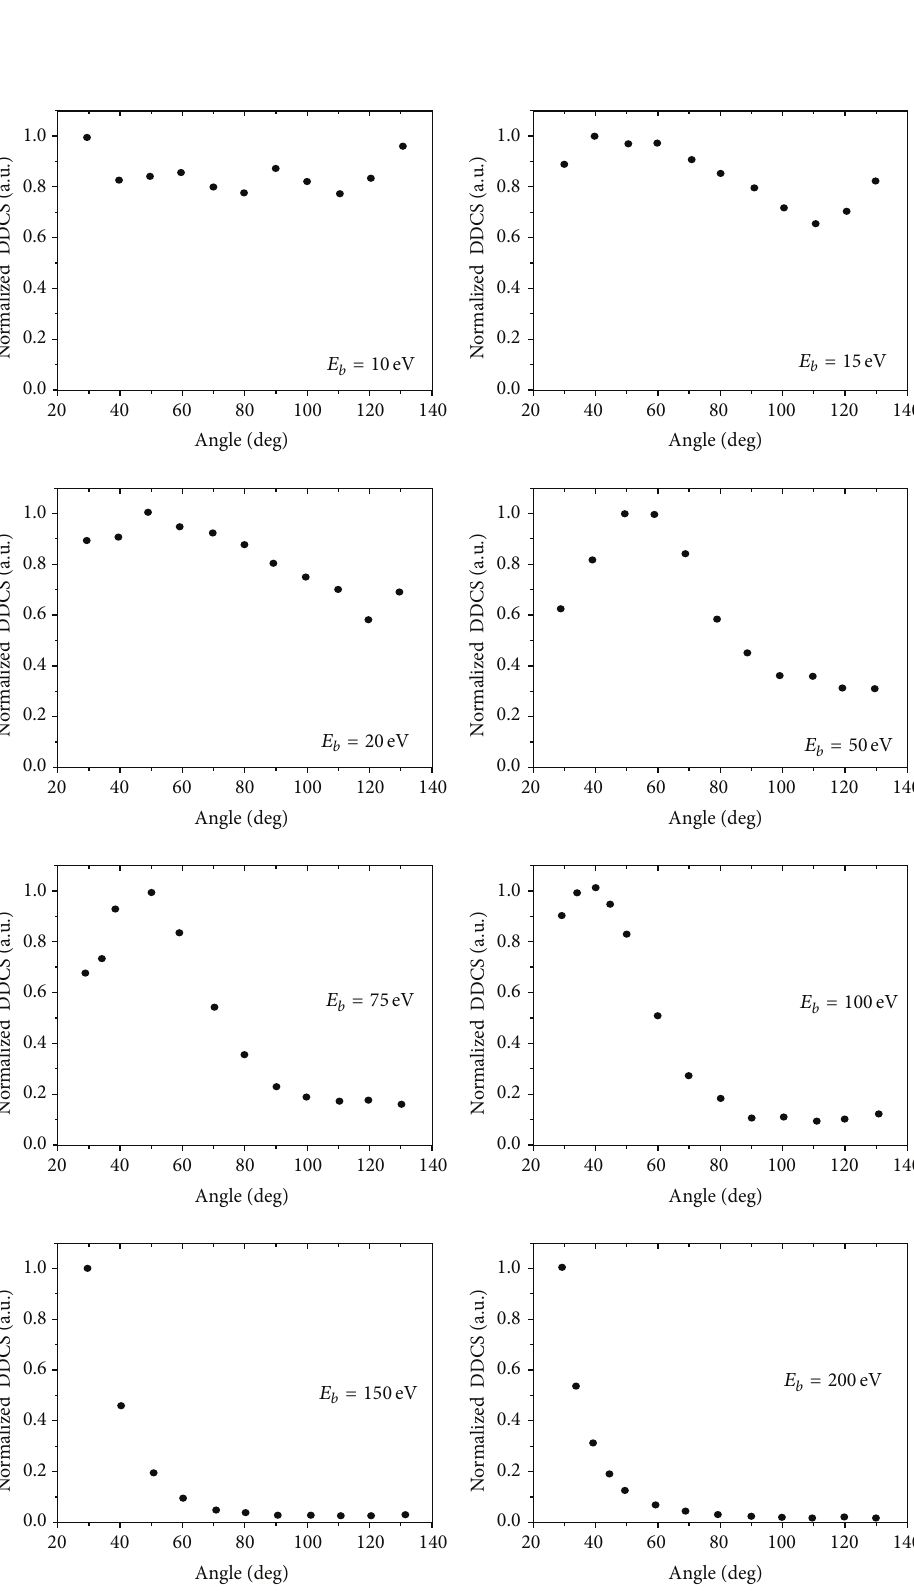
Figure 19: Present measurements of DDCSs of CH 4 for 10–200 eV detection electron